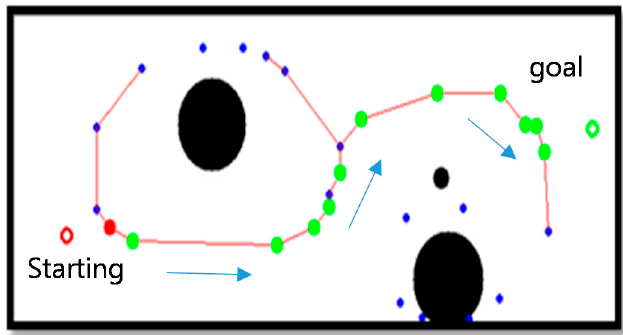
Figure 14. Shortest robot path by A* algorithm.